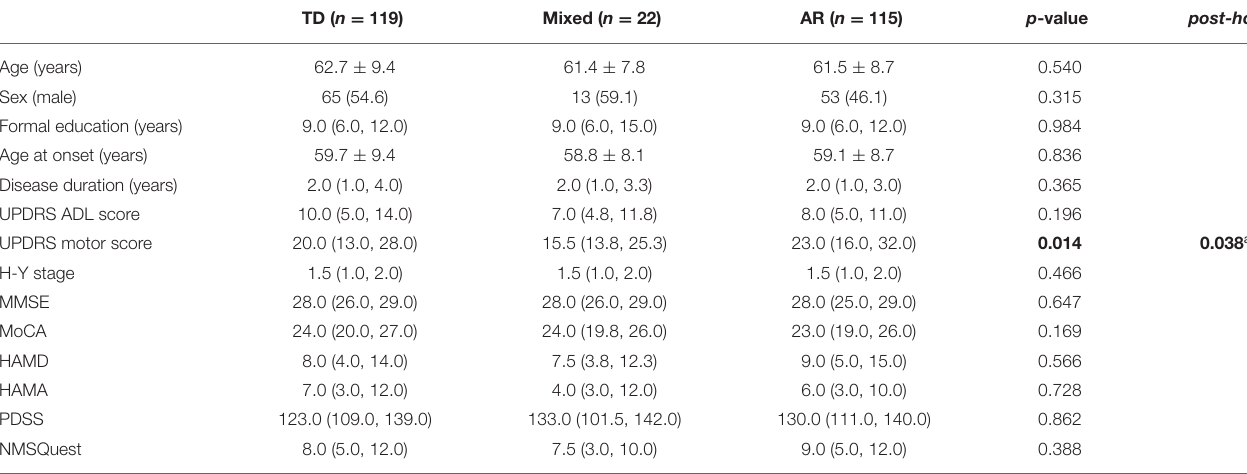
TABLE 2 | Comparison of the demographic and clinical characteristics of de novo Parkinson’s disease patients among the tremor-dominant/mixed/akinetic-rigid subgroups.